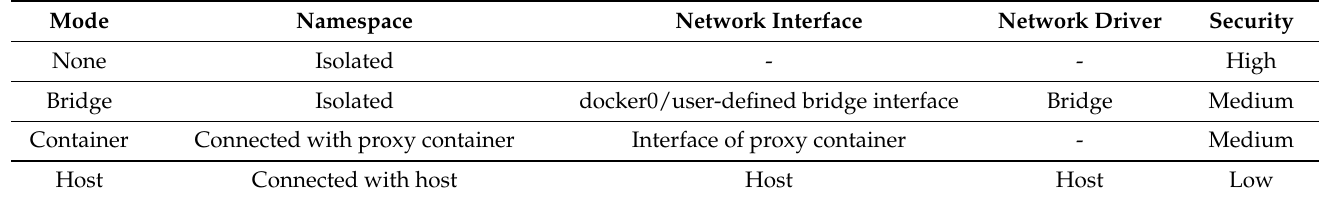
Table 1. Comparison according to communication method in a single host.